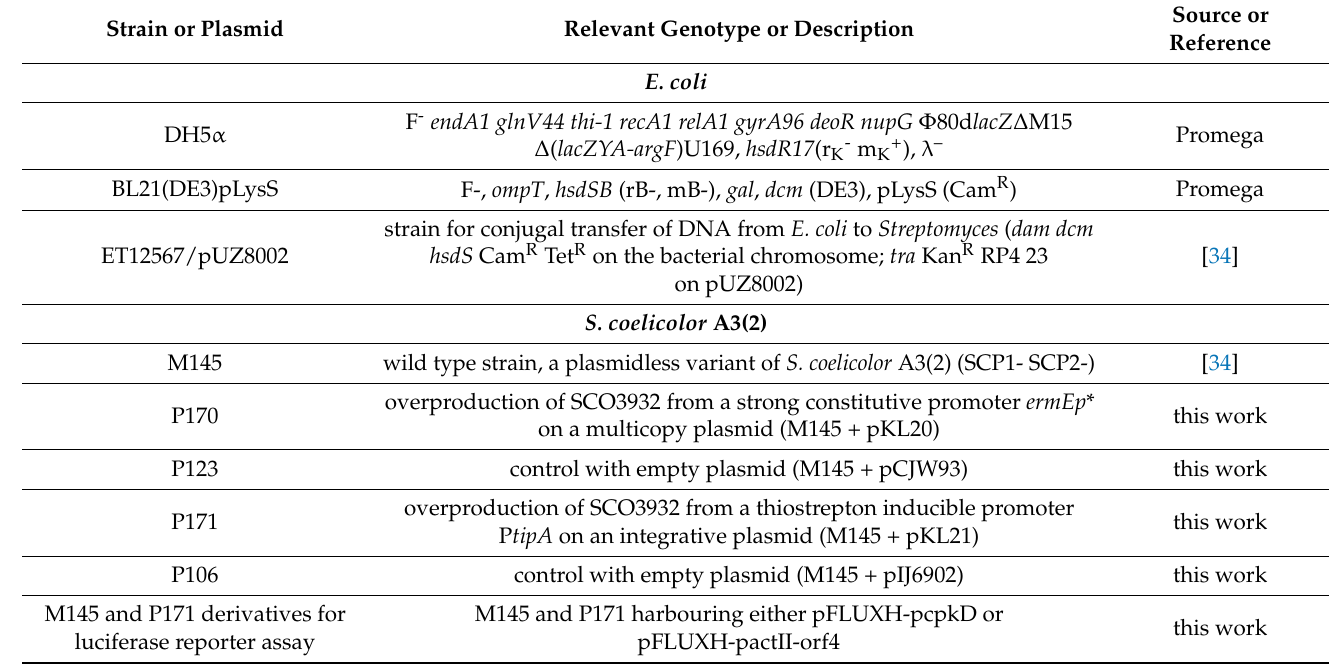
Table 3. Bacterial strains and plasmids used in this